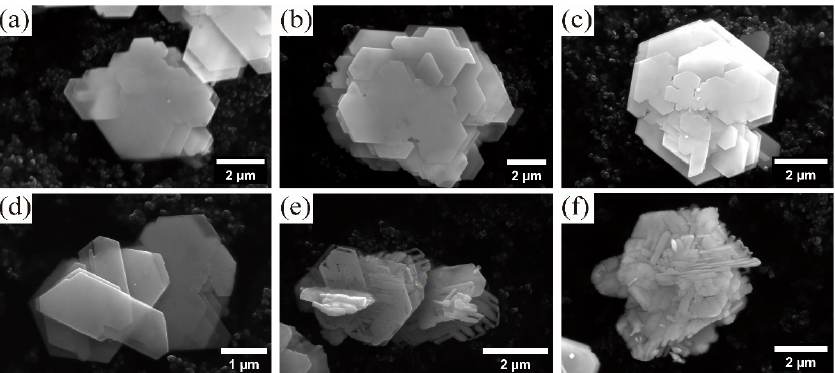
Figure 11. SEM images of powder after annealed at ( a ) 300 °C ( b ) 350 °C ( c ) 400 °C ( d ) 450 °C ( e ) 500 °C, and ( f ) 550